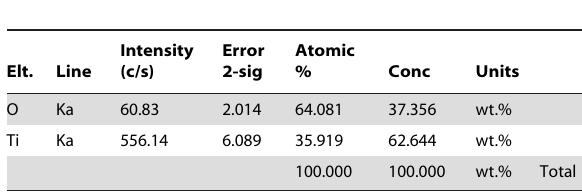
Table 3. EDS of Sample 1 after Calcination at 400 u C for 2